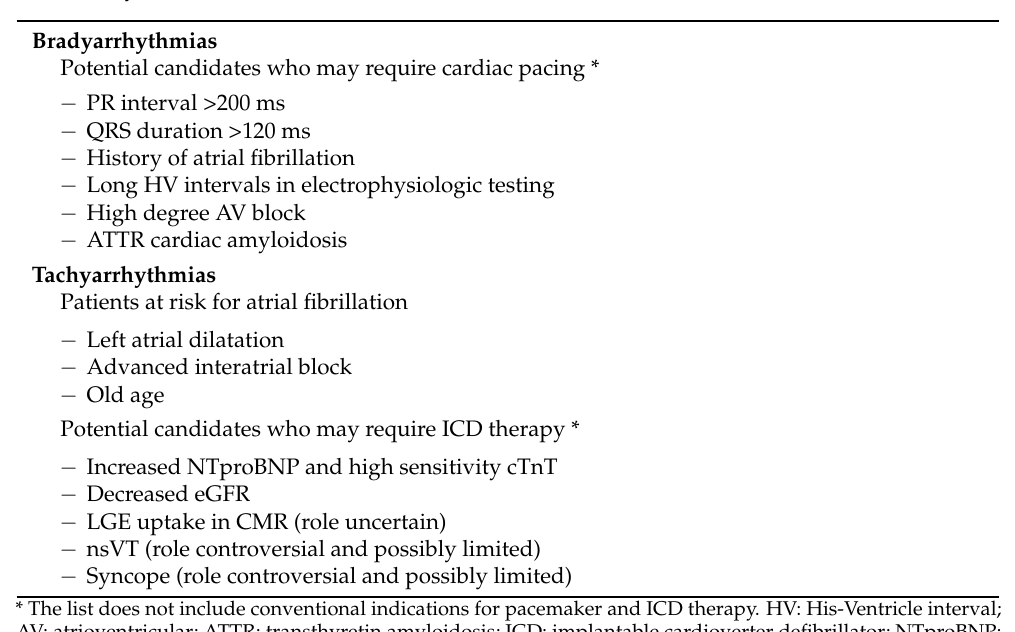
Table 3. Prognostic factors in the development of clinically relevant brady- and tachyarrhythmias in cardiac amyloidosis.